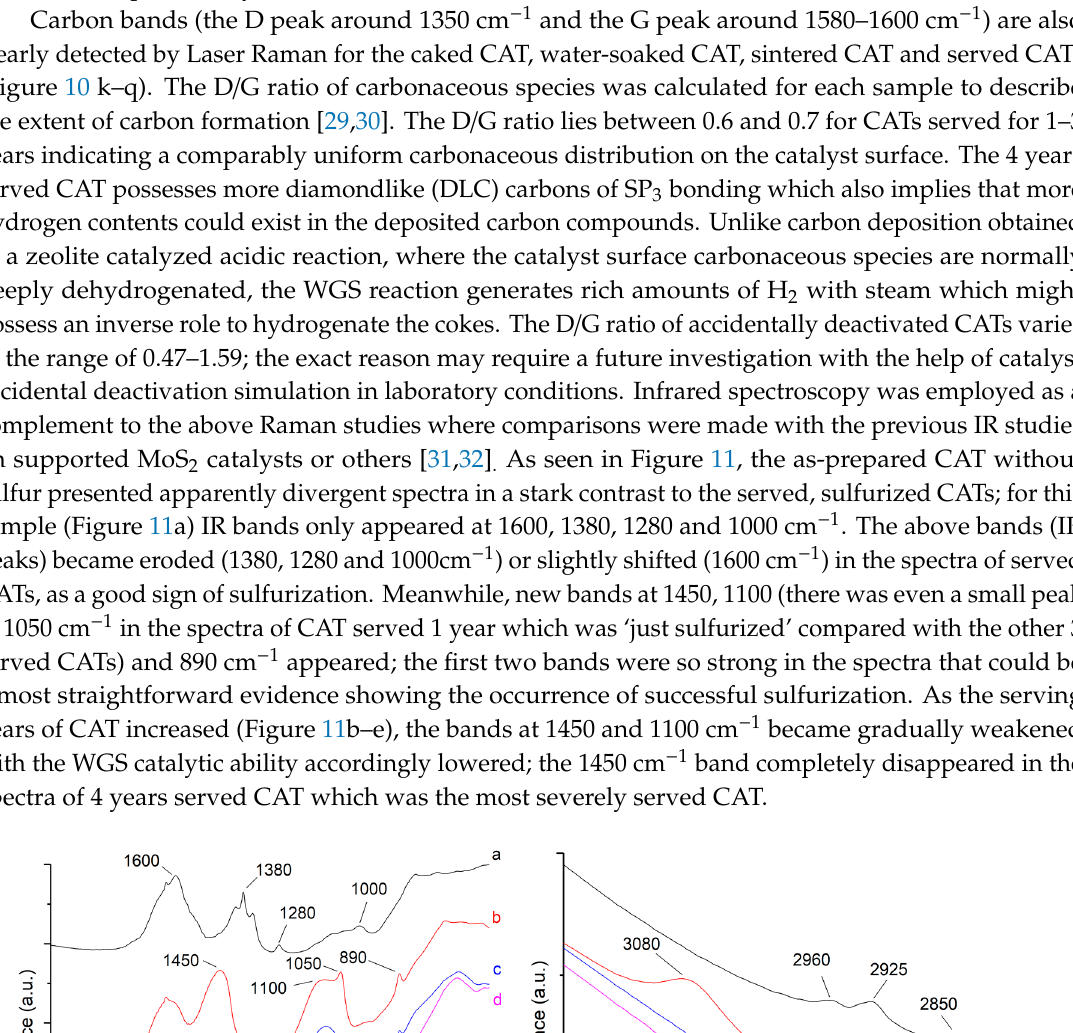
Figure 12. FT-IR spectra of CATs deactivated for different reasons ( f ) As; ( g ) Cl; ( h ) water soaked; ( i ) sintered; ( j ) caked 1; ( k ) caked 2. The above IR discussions indicated that CATs in a good sulfurized condition mainly possessed two bands at 1450 and 1100 cm − 1 , respectively. Both bands might be responsible for the effective sulfur tolerant WGS. However, only the change of 1450 cm − 1 band was noted more sensitive for those deactivated CATs, and therefore, it is more important to assess the remaining catalytic properties. Notably, this new finding was not reported in the previous studies of high steam/gas ratio sulfur tolerant WGS. Compared with the IR results, although more intensive in signals, Raman spectra only indicated an overall reduction of catalyst surface MoS 2 species on the deactivated CATs (Raman shifts at ~380 and ~410 cm − 1 ). 5. Experimental The CAT samples (Figure 13) were precisely unloaded from the plant and packed in vacuum at the same time. CATs served 1–4 years (Figure 13 c–f) were selected, and all accidentally deactivated CATs (Figure 13 g–l) only served for less than two years.